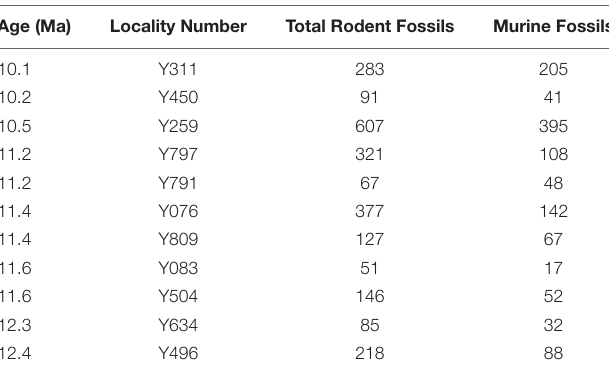
TABLE 1 | Potwar Plateau rodent localities utilized in this study, their ages, and fossil sample sizes.